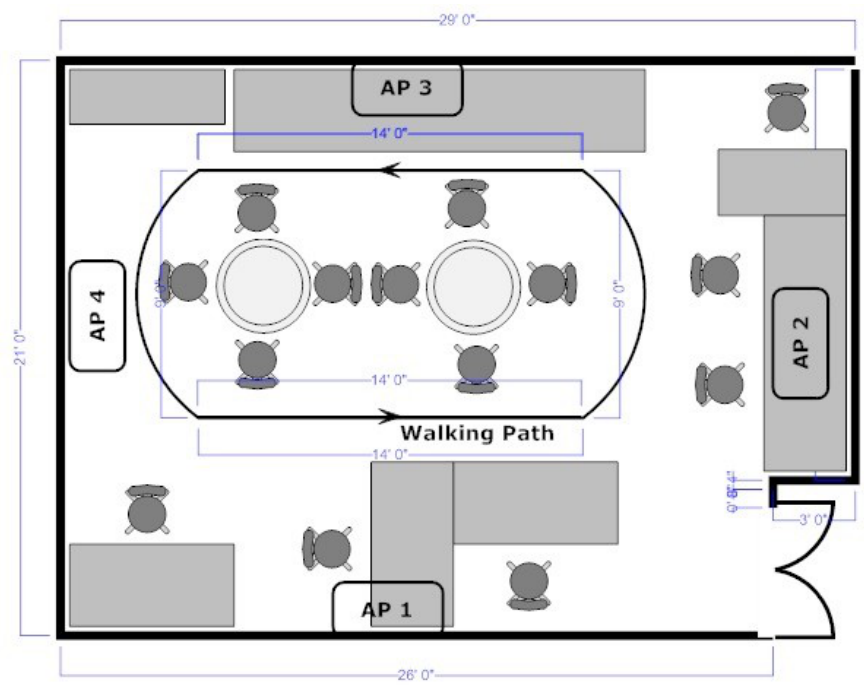
Figure 4. Experimental setup environment for network architecture with access point off the body. AP1, AP2, AP3 and AP4 mark the position of the four antennas of the